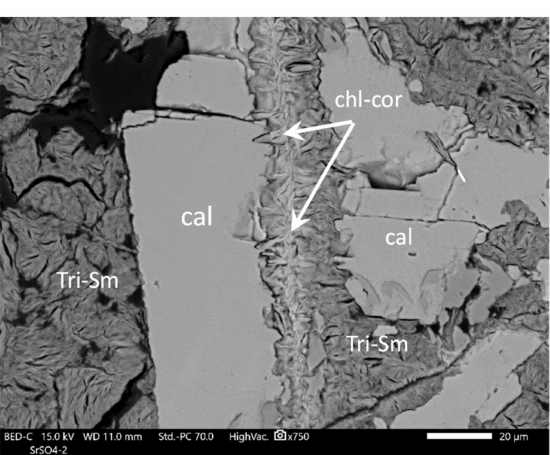
Figure 11. SEM petrographic observations in back-scattered electron mode. Chlorite and corrensite ( ± Chl/Cor) in veins postdating saponite (Tri-Sm) and calcite (cal). Basaltic lava at 405 m.